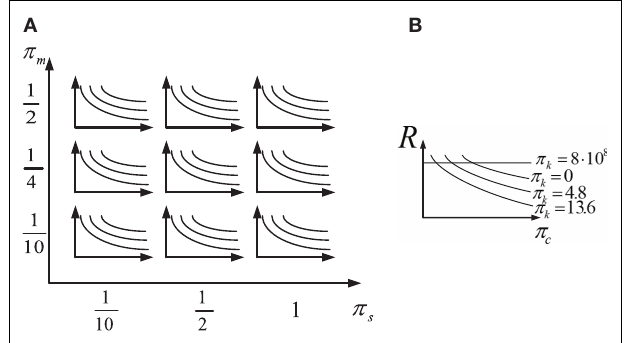
FIGURE 4 | General preview of a typical response presentation: (A) the matrix of graphs, (B) a cell in the matrix representing given wall and frame